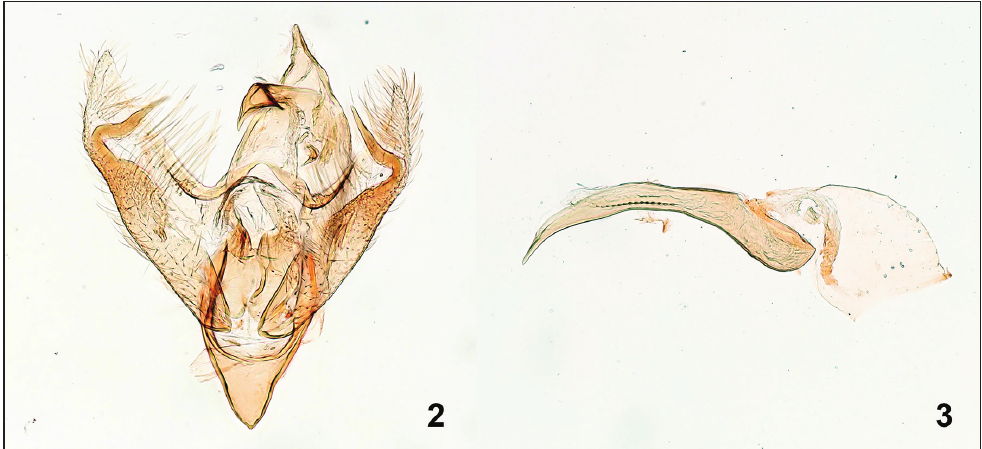
Figures 2–3. Male genitalia of Borkhausenia crimnodes Meyrick, 1912, Argentina, Paraná (BMNH). 2. Genitalia without phallus; 3. Phallus.